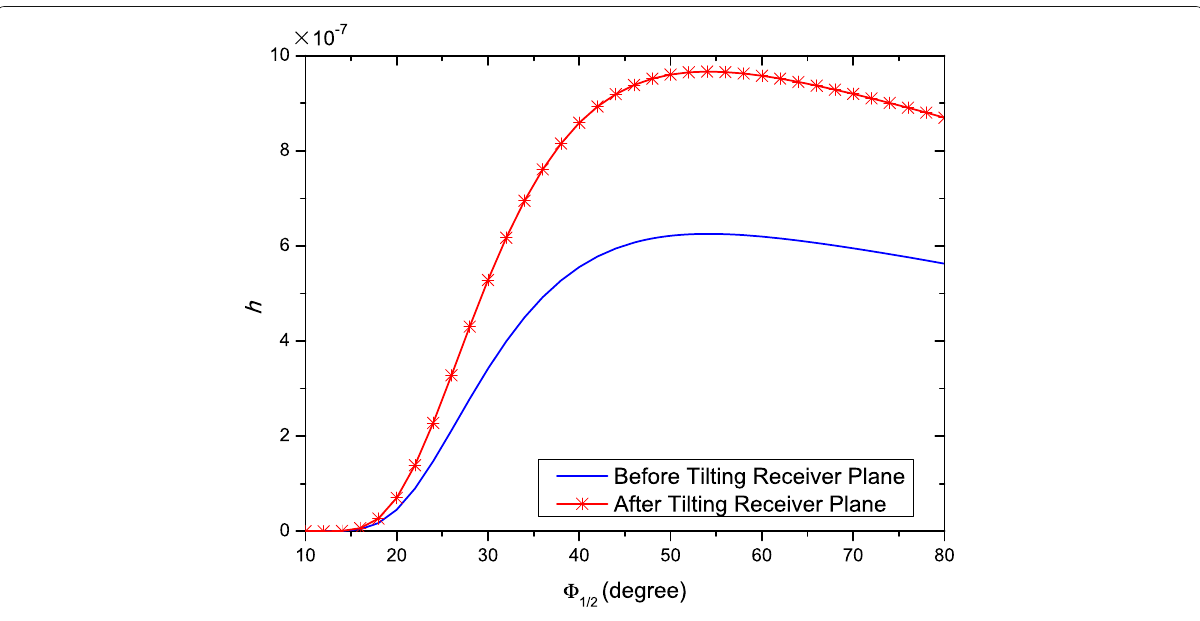
Fig. 7 Channel gain h versus the semi-angle at half power of the LED (cid:5) 1 / 2